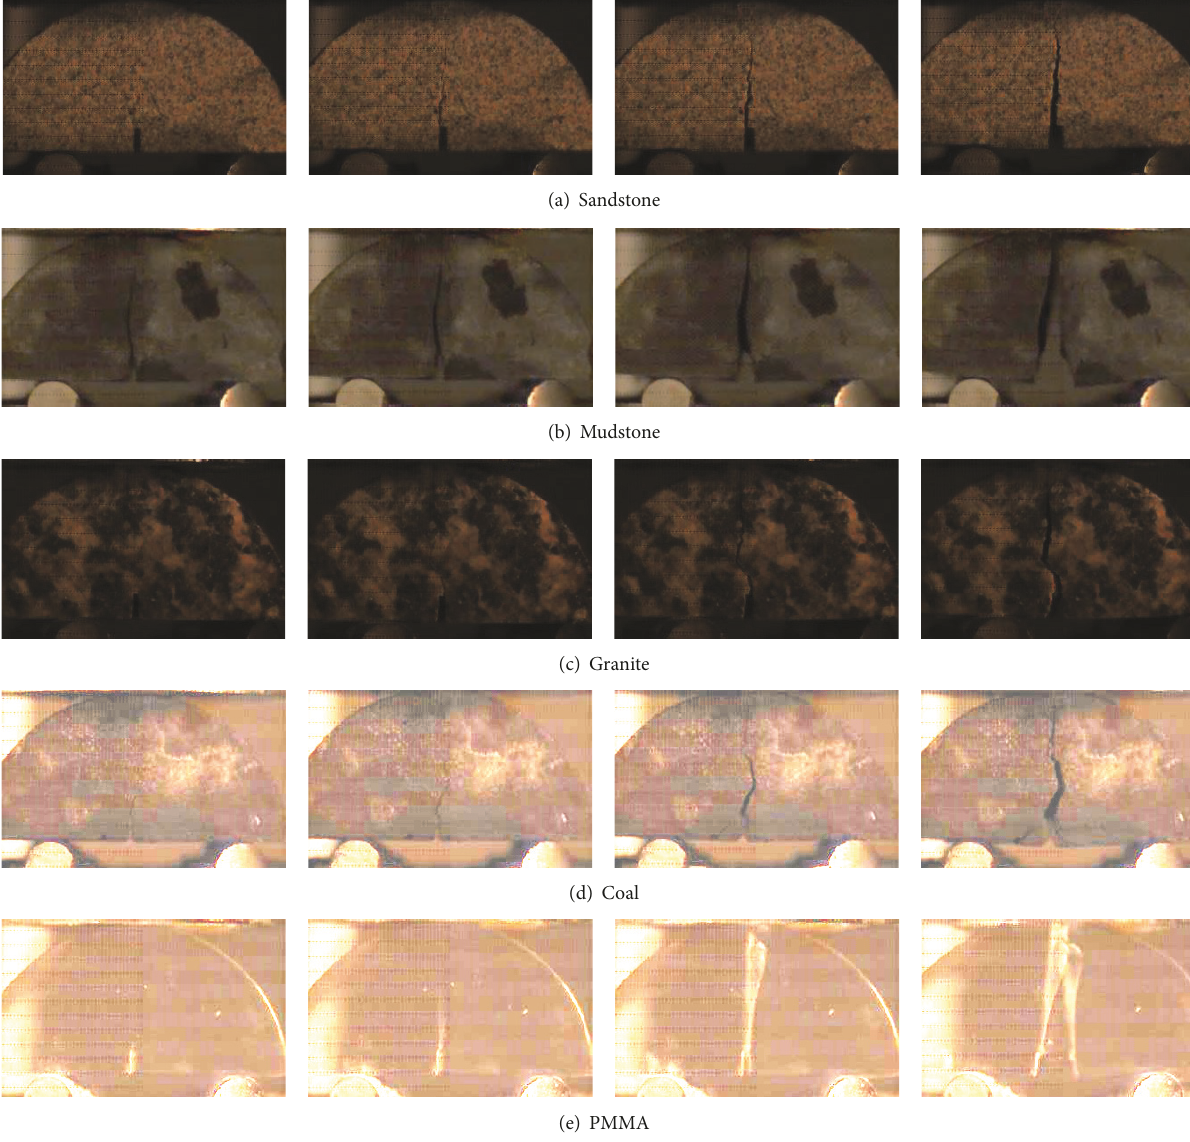
Figure 6: Process of rock specimen